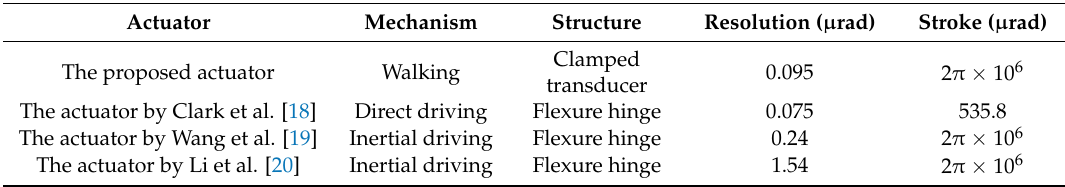
Table 4. Comparisons of several rotary precision